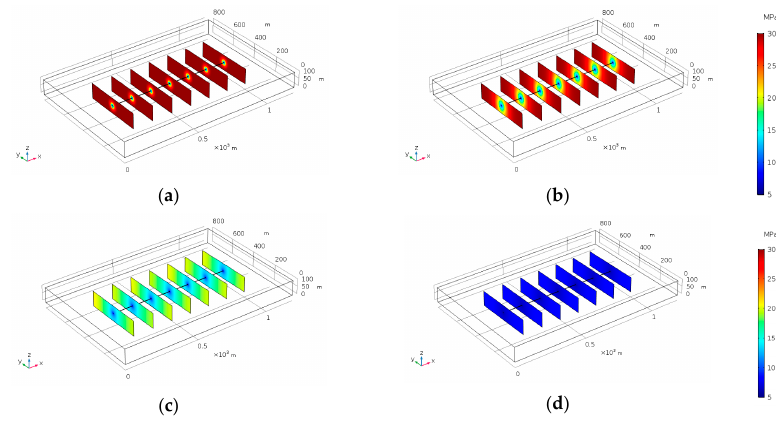
Figure 7. Pressure distribution in artificial fractures. ( a ) T = 0 d; ( b ) T = 1 d; ( c ) T = 2 d; ( d ) T = 3 d.